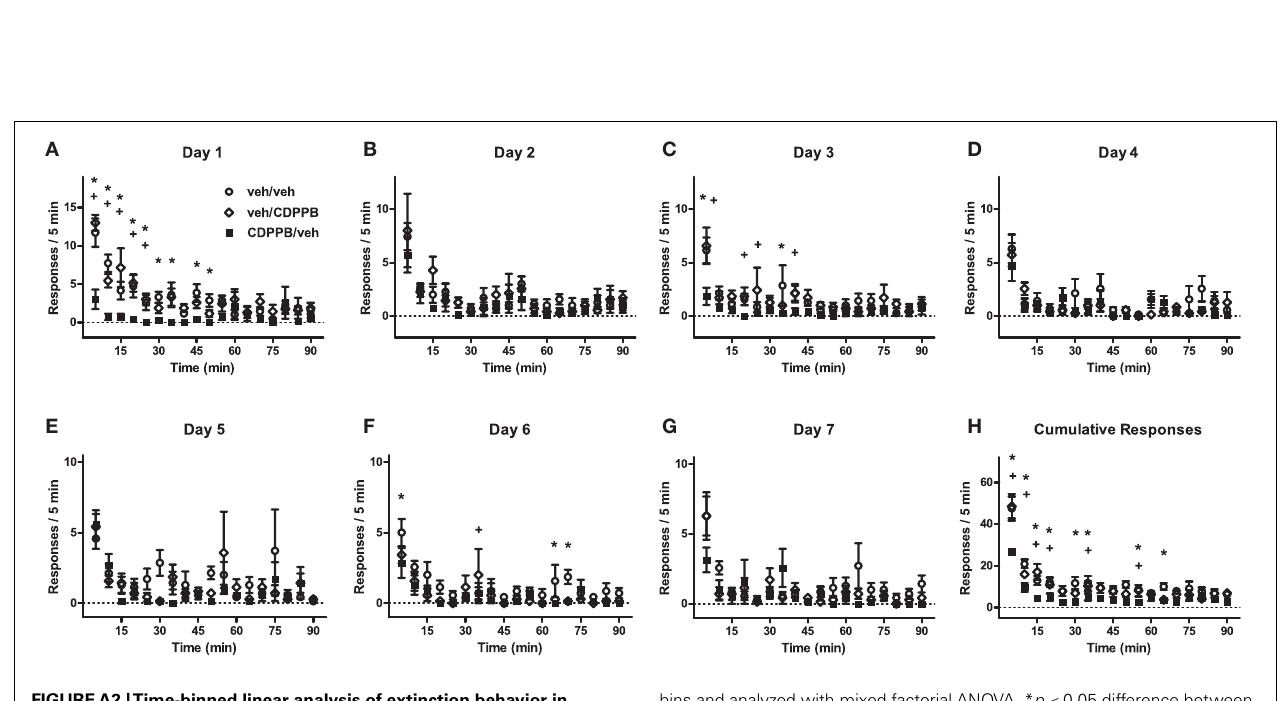
FIGUREA2 |Time-binned linear analysis of extinction behavior in Experiment 2. (A–G) Mean ( ± SEM) number of active lever responses from Days 1–7 of the first extinction training sequence, and (H) the per-subject average ( ± SEM) of cumulative responses, which were categorized into 5-min